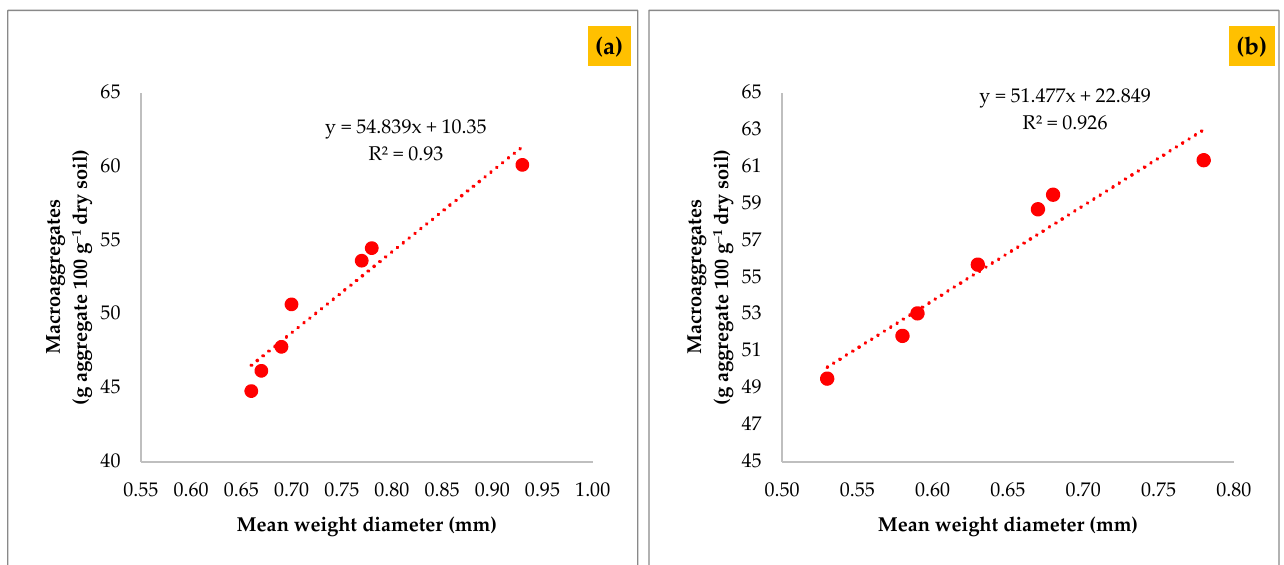
Figure 9. Relationship between macroaggregate and mean weight diameter fractions of soil aggre- gation; ( a ) 0–15 cm and ( b ) 15–30 cm soil depths. The regression lines for macroaggregate versus MWD showed a positive linear rela- tionship (macroaggregate = 54.839x + 10.35 and 51.477x + 22.849) in the 0–15 and 15–30 cm soil depth. However, microaggregates and MWD had a significantly strong negative rela- tionship (R 2 = 0.89, p < 0.01; Figure 10a) in 0–15 cm soil depth and in 15–30 cm soil depth (R 2 = 0.86, p < 0.01; Figure 10b).